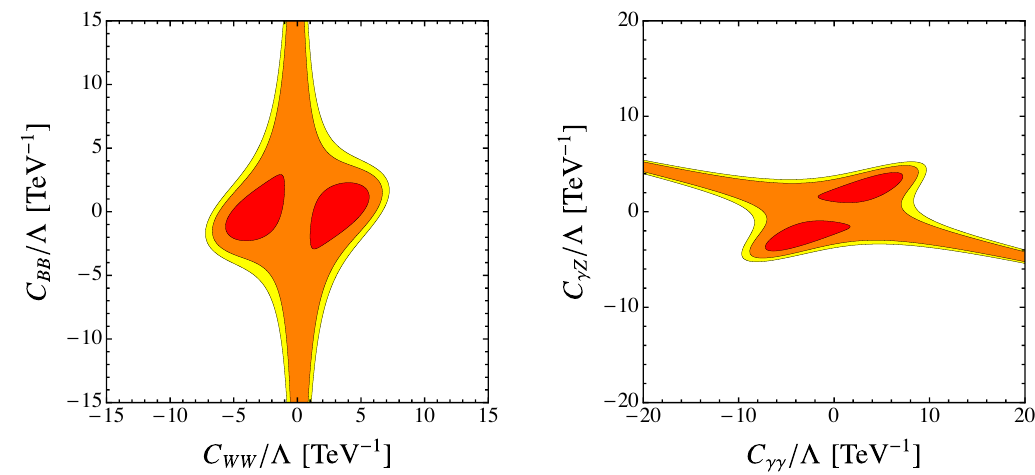
WW (cid:0) C BB (left) = 0 Zh